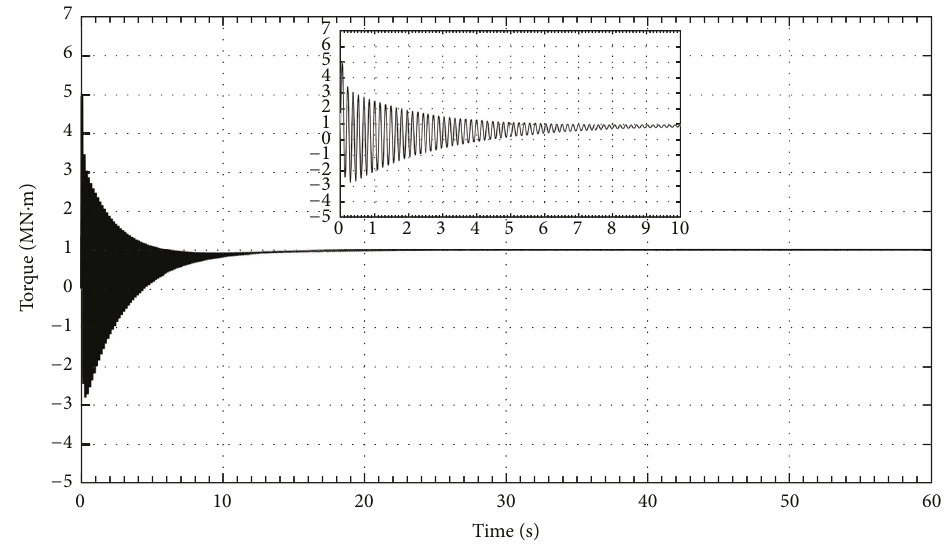
Figure 5: Rotor-blade exerted torque.